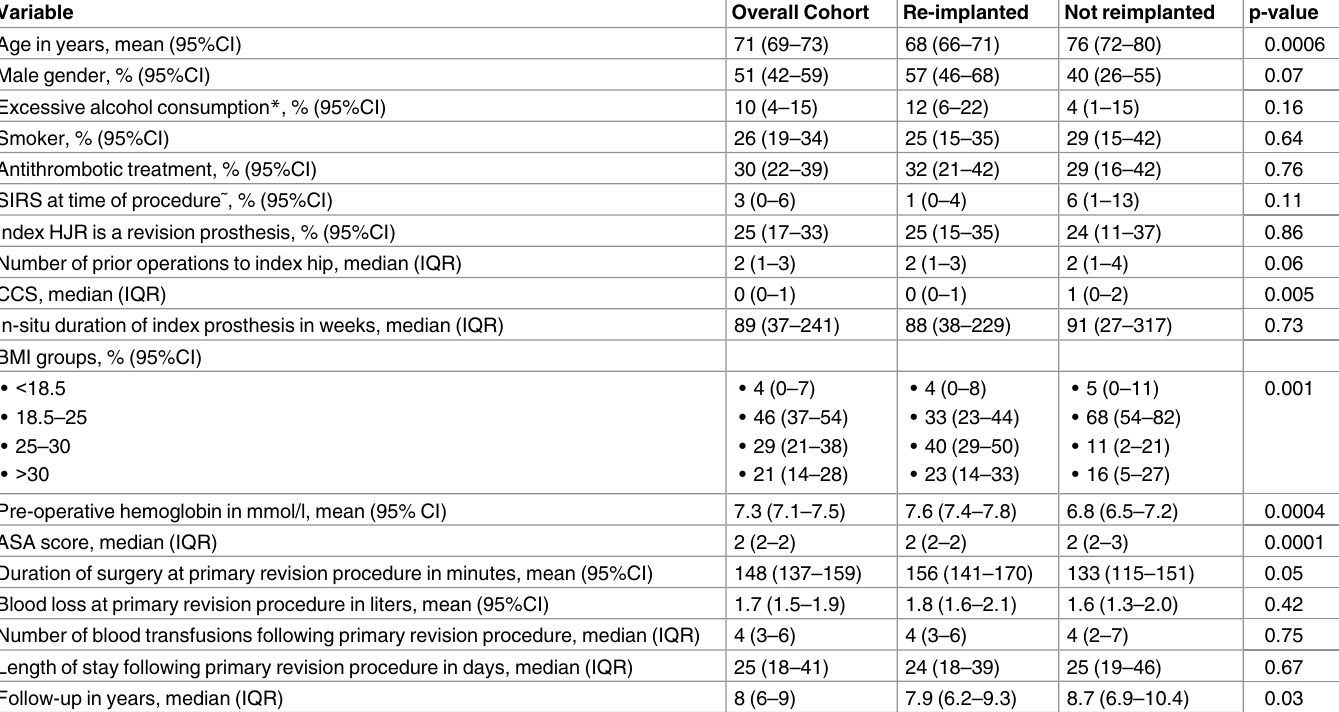
Table 3. Baseline demographics of 130 patients treated for chronic hip Periprosthetic Joint Infection between 2003 and